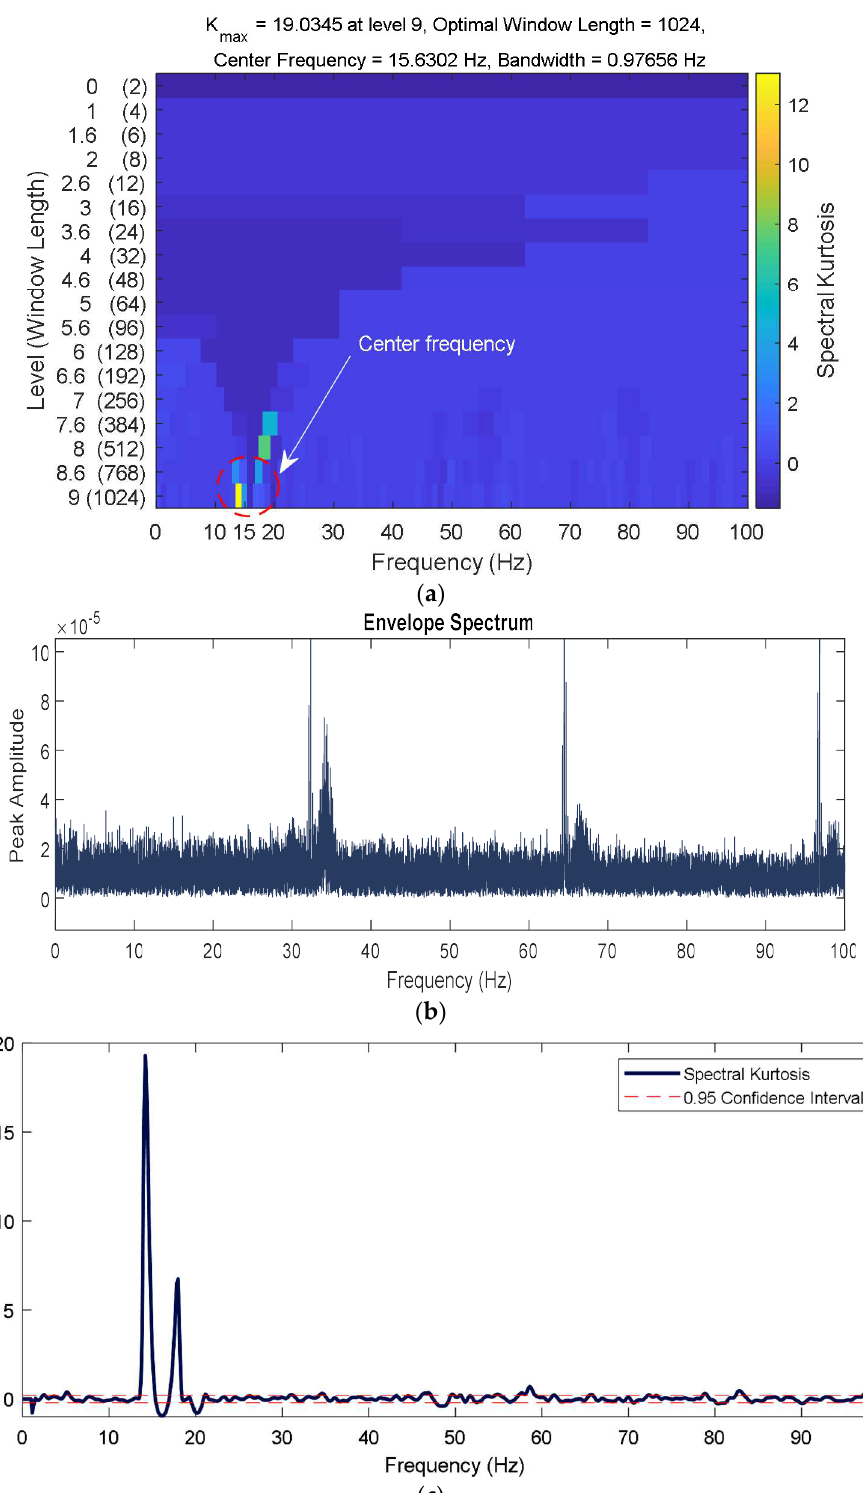
Figure 16. TST PMSG stator current with imbalanced rotor blades: ( a ) kurtogram; ( b ) envelope spectrum of the filtered signal, and ( c ) the spectral kurtosis (SK).